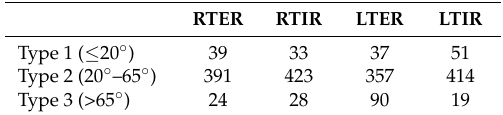
Table 2. Type values of each rotation and number of subjects of rotation